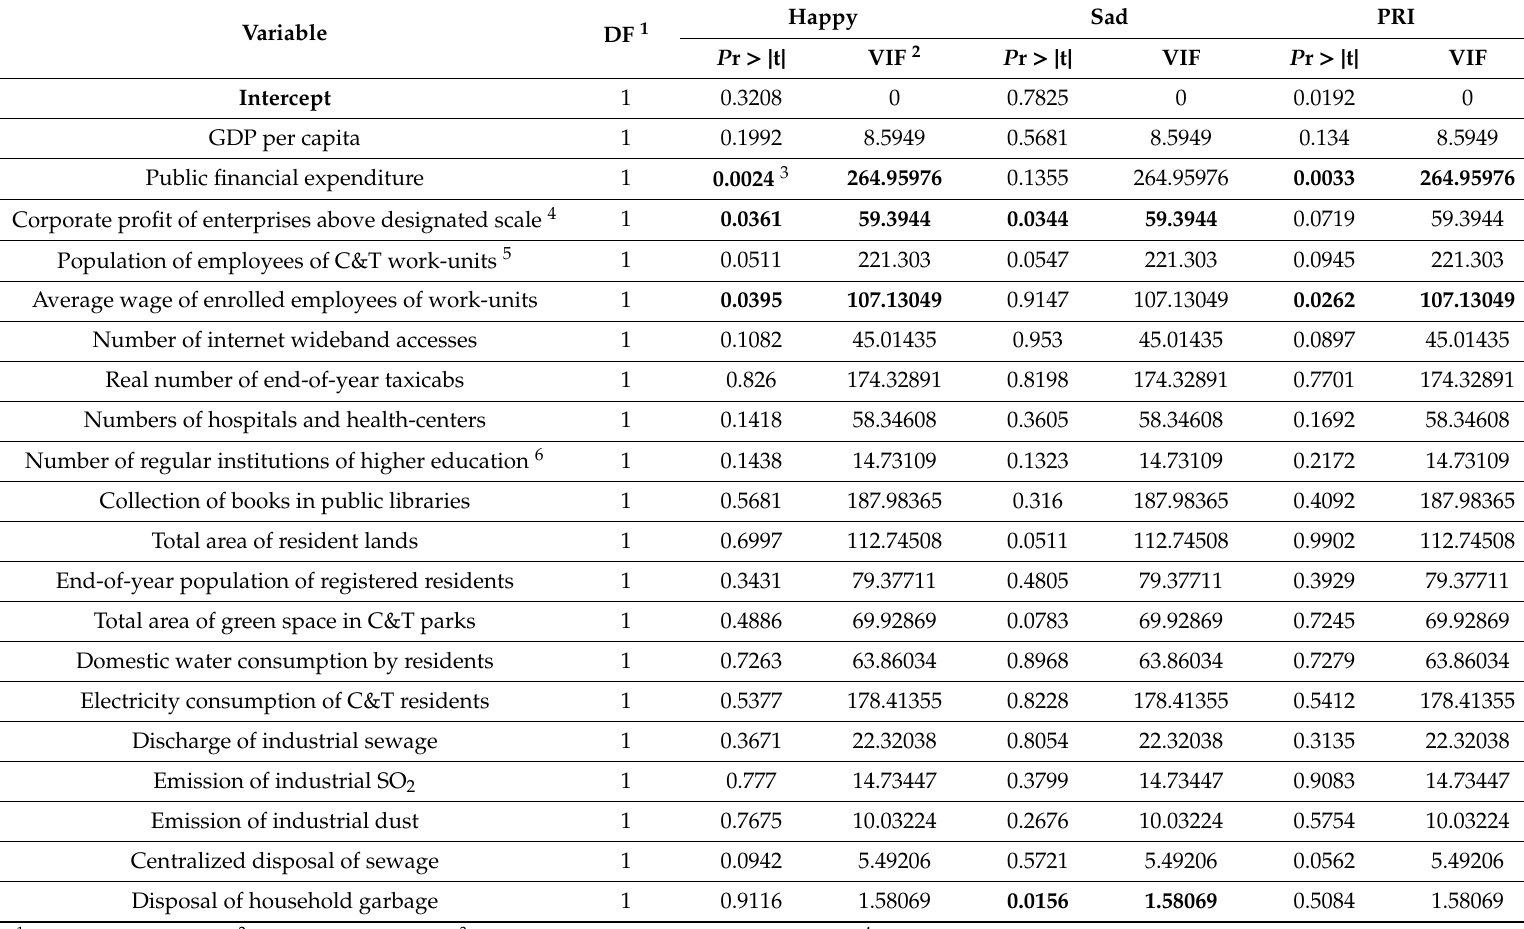
Table 3. The analysis of collinearity among city variables on ranked scores of happy and sad expressions, and positive response index (PRI) in visitors at university campuses across mainland